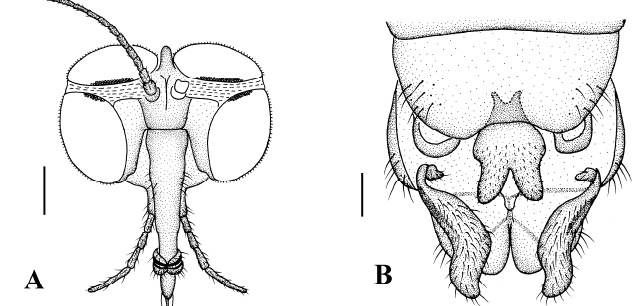
Figure 7. Blepharicera dushanzica sp. nov. (female paratype). ( A ) female head, frontal view ( B ) female terminalia, ventral view. Scale bars: 0.25 mm ( A ), 0.10 mm ( B ). Distribution. Currently known only from China